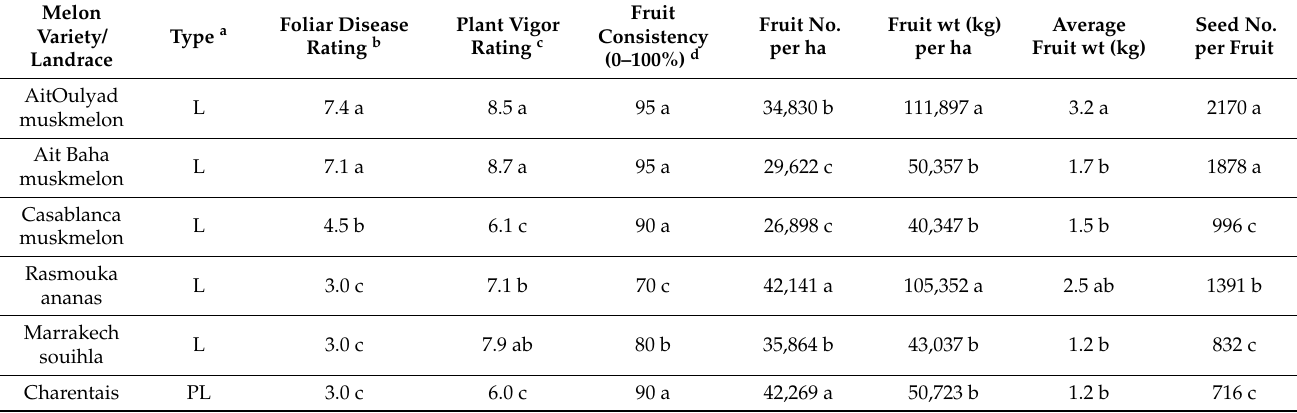
Table 1. Melon ( Cucumis melo ) landrace/pure line evaluations in Belfaa, Morocco combined for 2015 and 2016. Melon